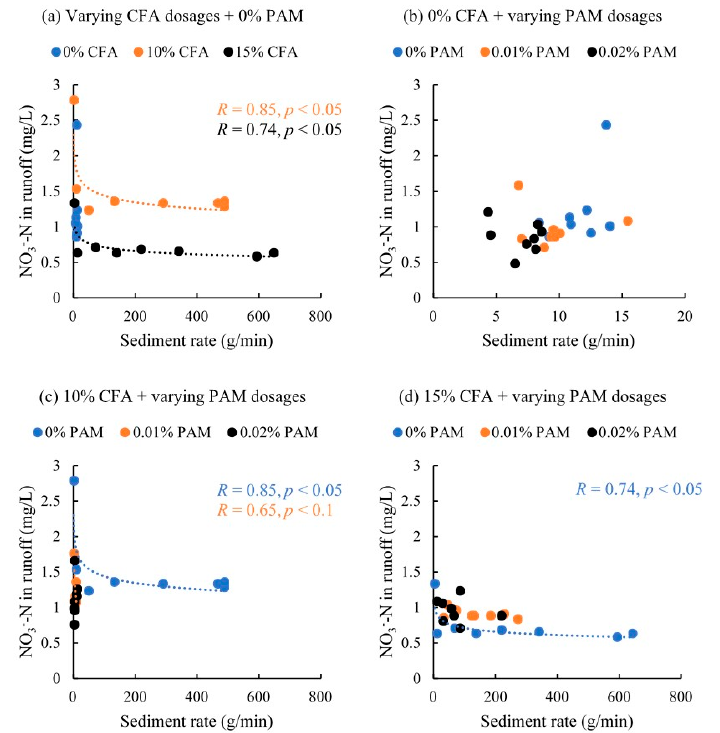
Figure 6. Correlation between NO 3 − -N concentration in runoff and sediment rate for varying CFA dosages + 0% PAM ( a ), 0% CFA + varying PAM dosages ( b ), 10% CFA + varying PAM dosages ( c ), 15% CFA + varying PAM dosages ( d ).